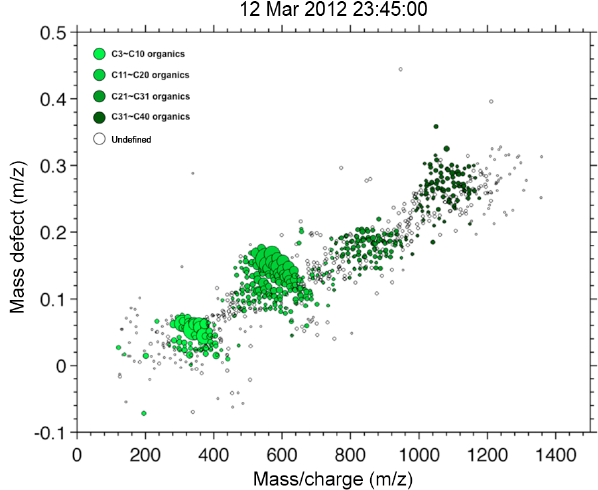
Figure 3. Mass defect plot of negative ambient ions observed dur- ing the night-time on 13 March 2012. The four bands represent the HOMs containing approximately 10, 20, 30 and 40 carbon atoms (four α -pinene units). The majority of the HOMs have NO − core